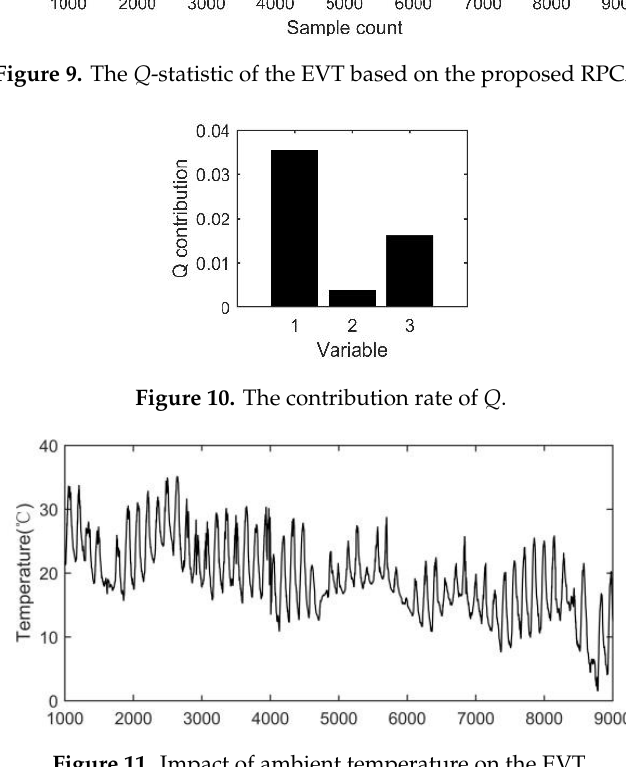
Figure 11. Impact of ambient temperature on the EVT.